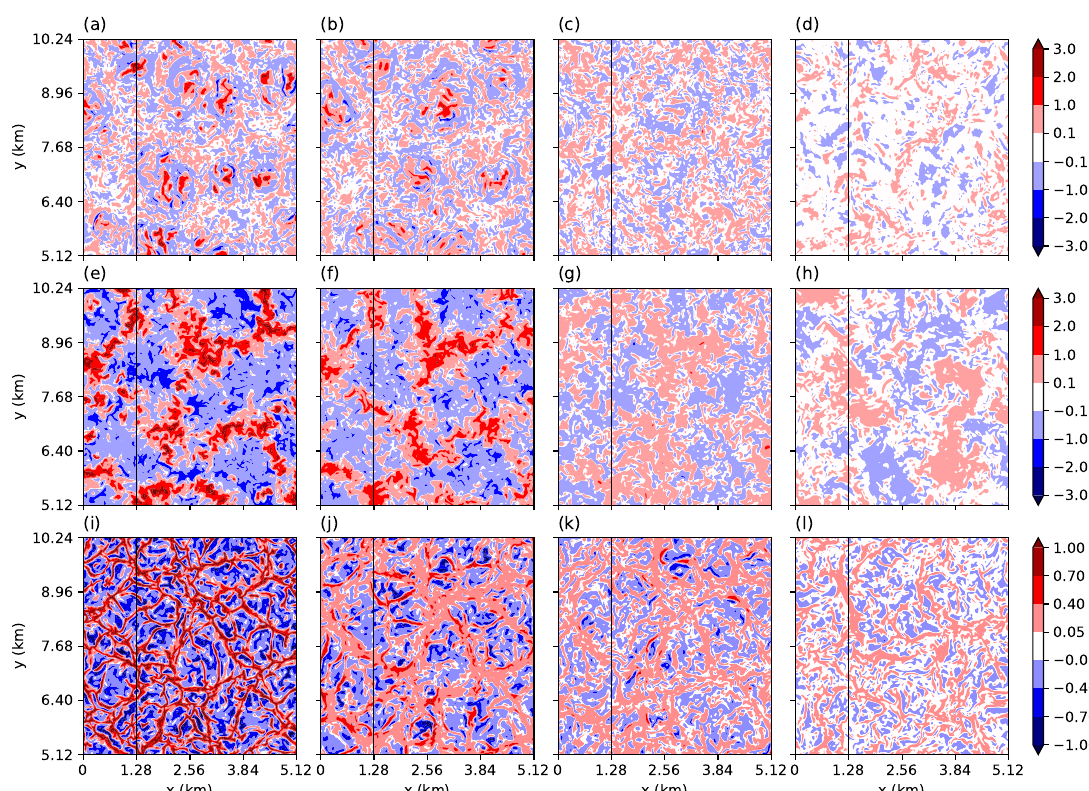
Figure 2. Vertical velocity fields at z = 940 m and t − t c = ( a ) 0, ( b ) 604, ( c ) 1202, and ( d ) 3603 s and the same fields at z = ( e – h ) 460 and ( i – l ) 40 m. The upperleft quarter of the horizontal domain is shown. The black lines indicate the position of the y - z plane in Figure